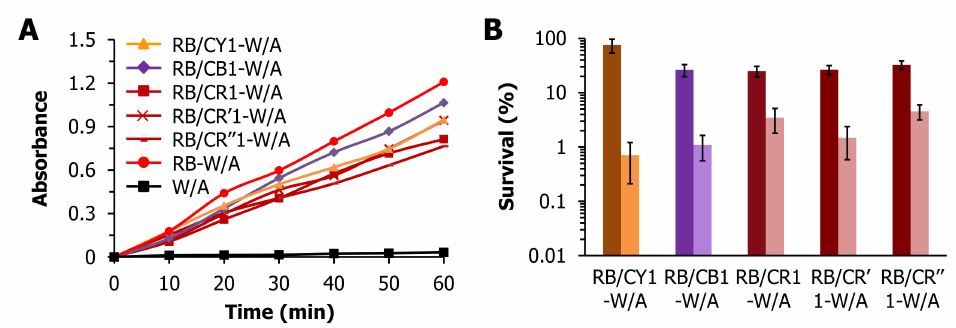
Figure 4. ( A ) The absorbance of I 3 − (352 nm) in the 0.5 M KI solution that underwent photooxidation by RB / CY1-W / A (orange), RB / CB1-W / A (purple), RB / CR1-W / A, RB / CR (cid:48) 1-W / A and RB / CR”1-W / A (maroon), in comparison with a PS-free light control (black) as a function of illumination time (0–60 min). ( B ) Photodynamic antibacterial studies against S. aureus using RB / CY1-W / A, RB / CB1-W / A, RB / CR1-W / A, RB / CR (cid:48) 1-W / A and RB / CR”1-W / A. Displayed is the % survival for each sample in the dark (dark bar) and light (light bar) conditions. The light conditions were as in Figure